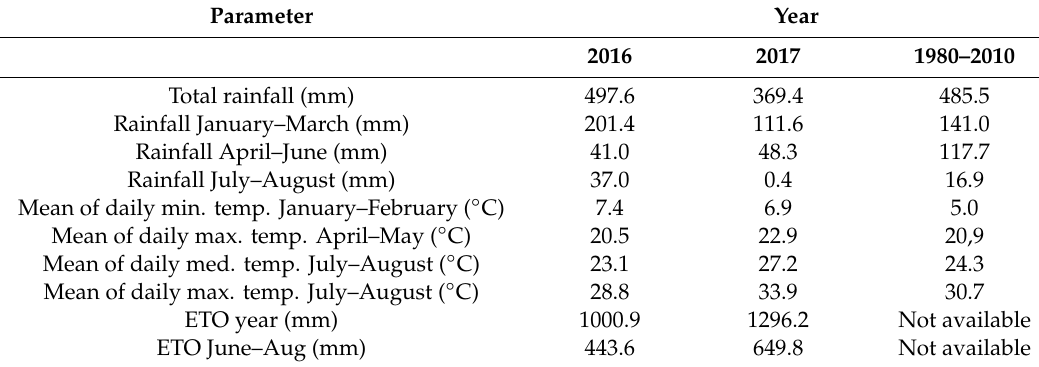
Table 1. Main climatic factors recorded during 2016, 2017 and the 30-year period 1980–2010 in Sassari (Sardinia,